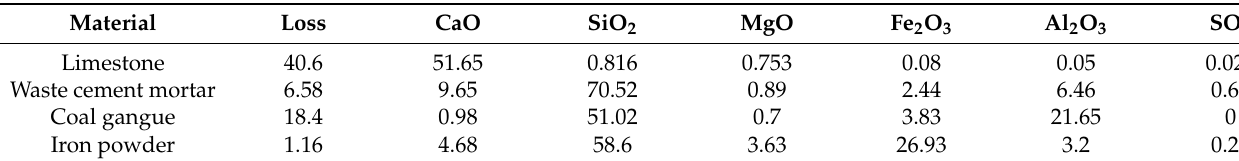
Table 1. Chemical composition of raw materials (wt.%).